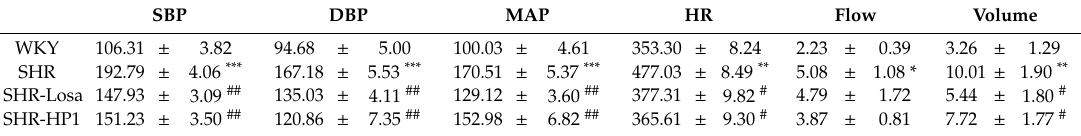
Figure 1. High-performance liquid chromatography (HPLC) chromatograms (detection at 330 nm) of Quercetin-3-O-glucuronide from Vitis labrusca leaves extract (HP1) extract. Standard ( A ) and HP1 extract ( B ). Table 1. Analysis of cardiac function characteristics by HP1-treated in